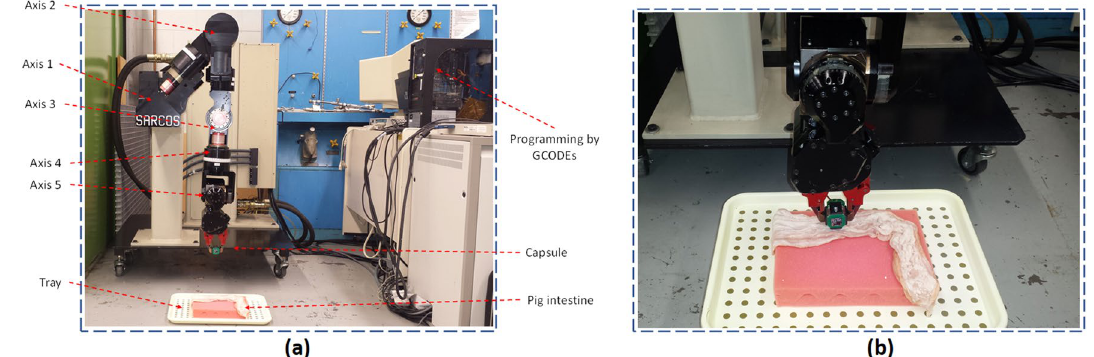
Figure 8. ( a ) Robotic arm experimental setup, ( b ) Capsule placement and porcine intestine.